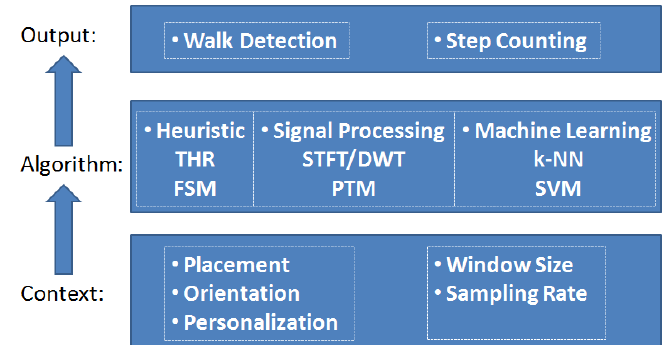
Figure 1. The method of context impacts the algorithm and output. THR, threshold; PTM, Pan- Tompkins method.